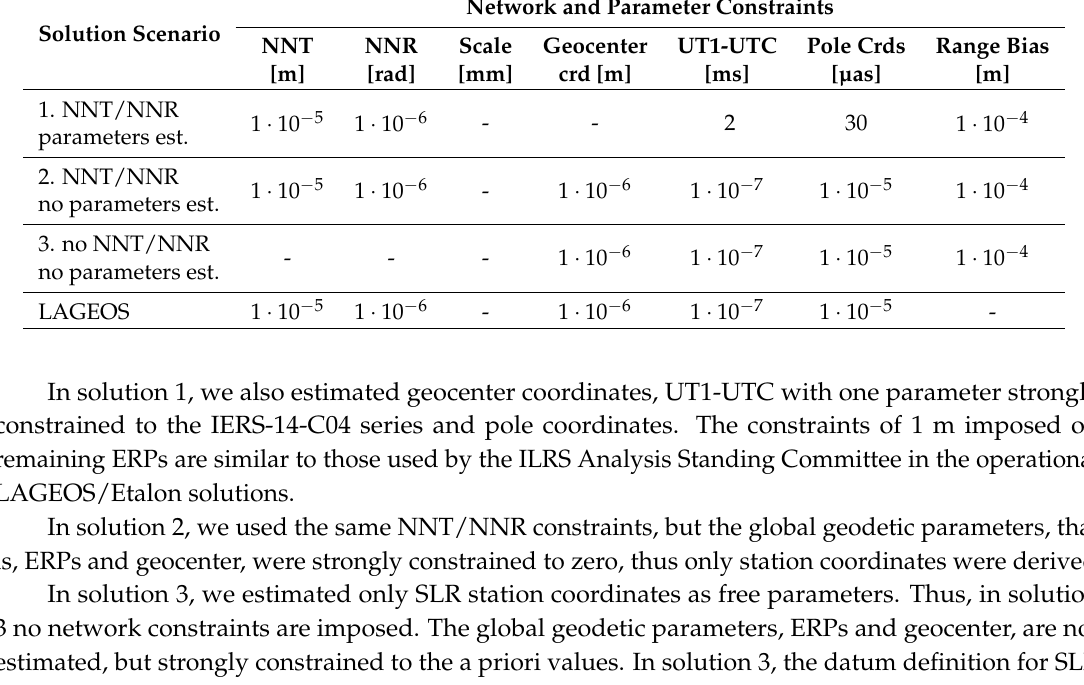
Table 1. Constraints in tests of different network realization scenarios and different sets of estimated global parameters for S3A/B and LAG